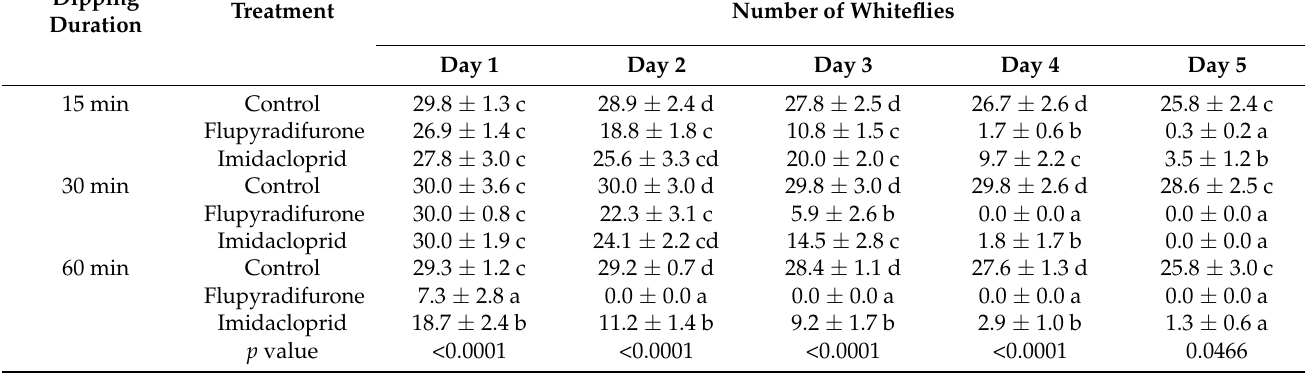
Table 1. Effects of cutting dips of varying length and with two insecticides or water in causing mortality in adult B. tabaci whiteflies placed on newly sprouted plants derived from those cuttings. Results presented are mean whitefly abundances per plant ± SE Z